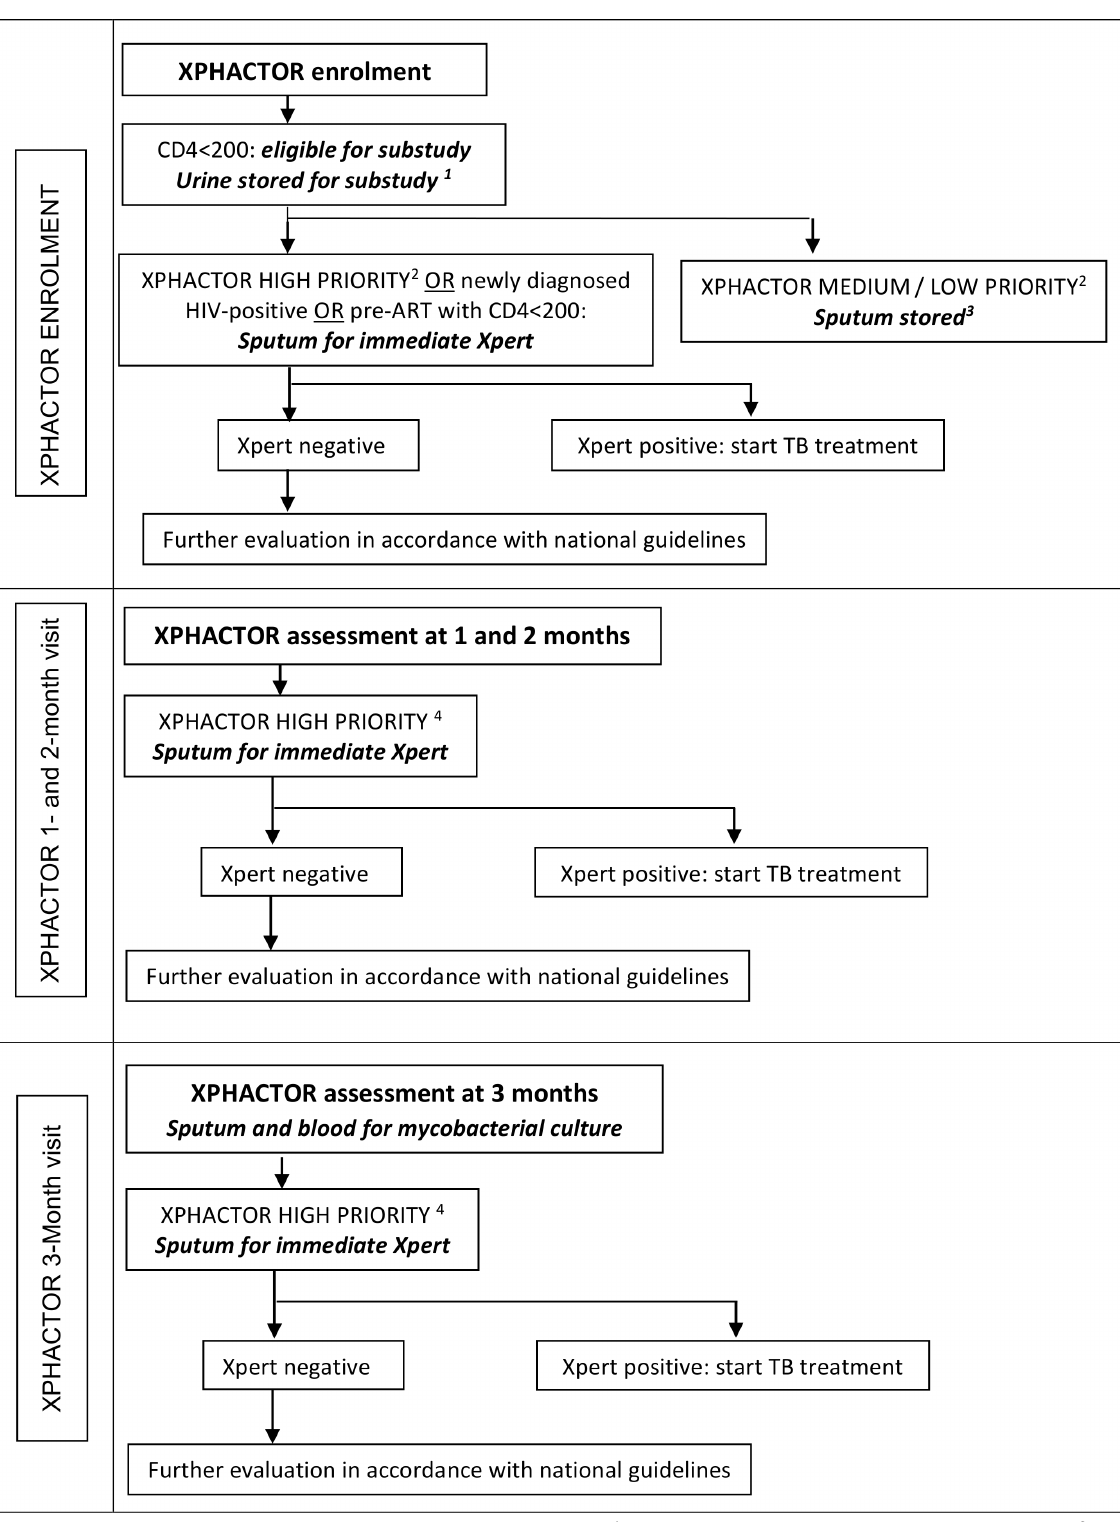
Fig 1. XPHACTOR study flow and entry point to the LAM substudy. 1 Samples tested with LF-LAM at the end of the study. 2 High priority (any of: current cough, fever (cid:1) 3 weeks, body mass index (BMI) < 18.5 kg/m 2 , CD4 < 100x10 6 /l, measured weight loss (cid:1) 10% in preceding 6 months, or other feature raising high clinical suspicion of TB); medium priority (any of: fever < 3 weeks,